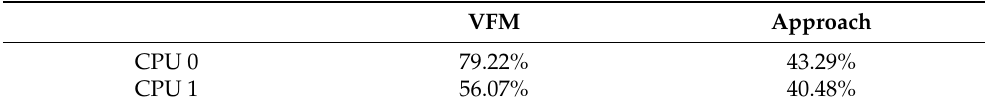
Table 7. Processor usage